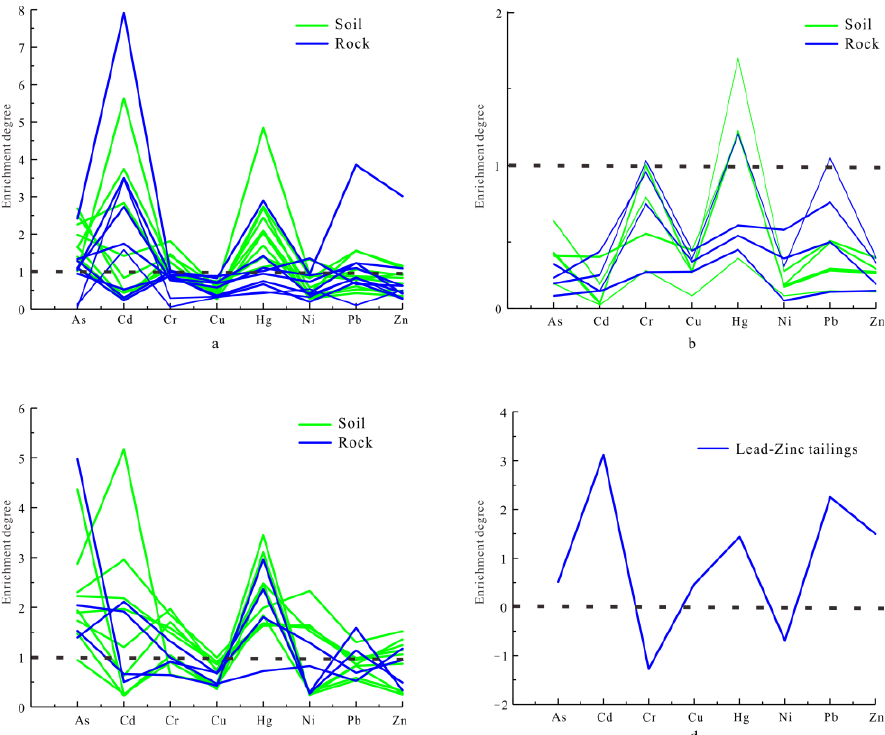
Figure 7. Degree of toxic metal enrichment in each sediment source. ( a ): Limestone; ( b ): Dolomite; ( c ): Sand-shale and mudstone; ( d ): Lead-zinc tailings (with logarithmic scale). The background geology contributes more than 95% of the catchment